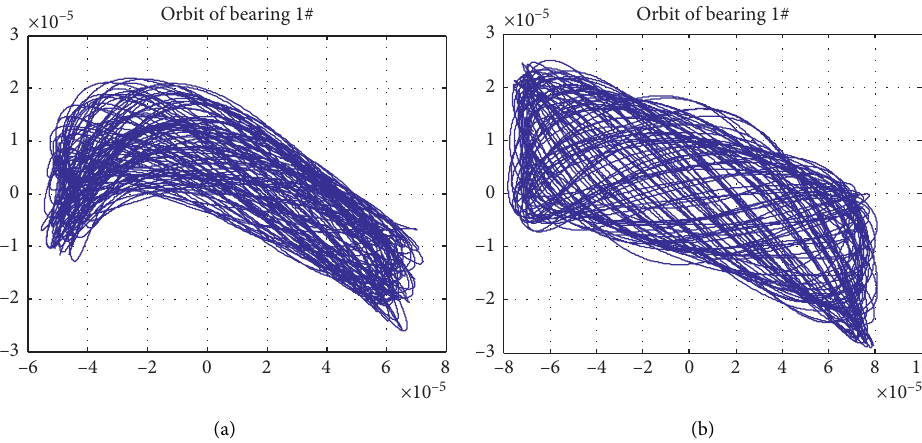
Figure 30: Orbits of bearing 1 at different misalignment ( Ω